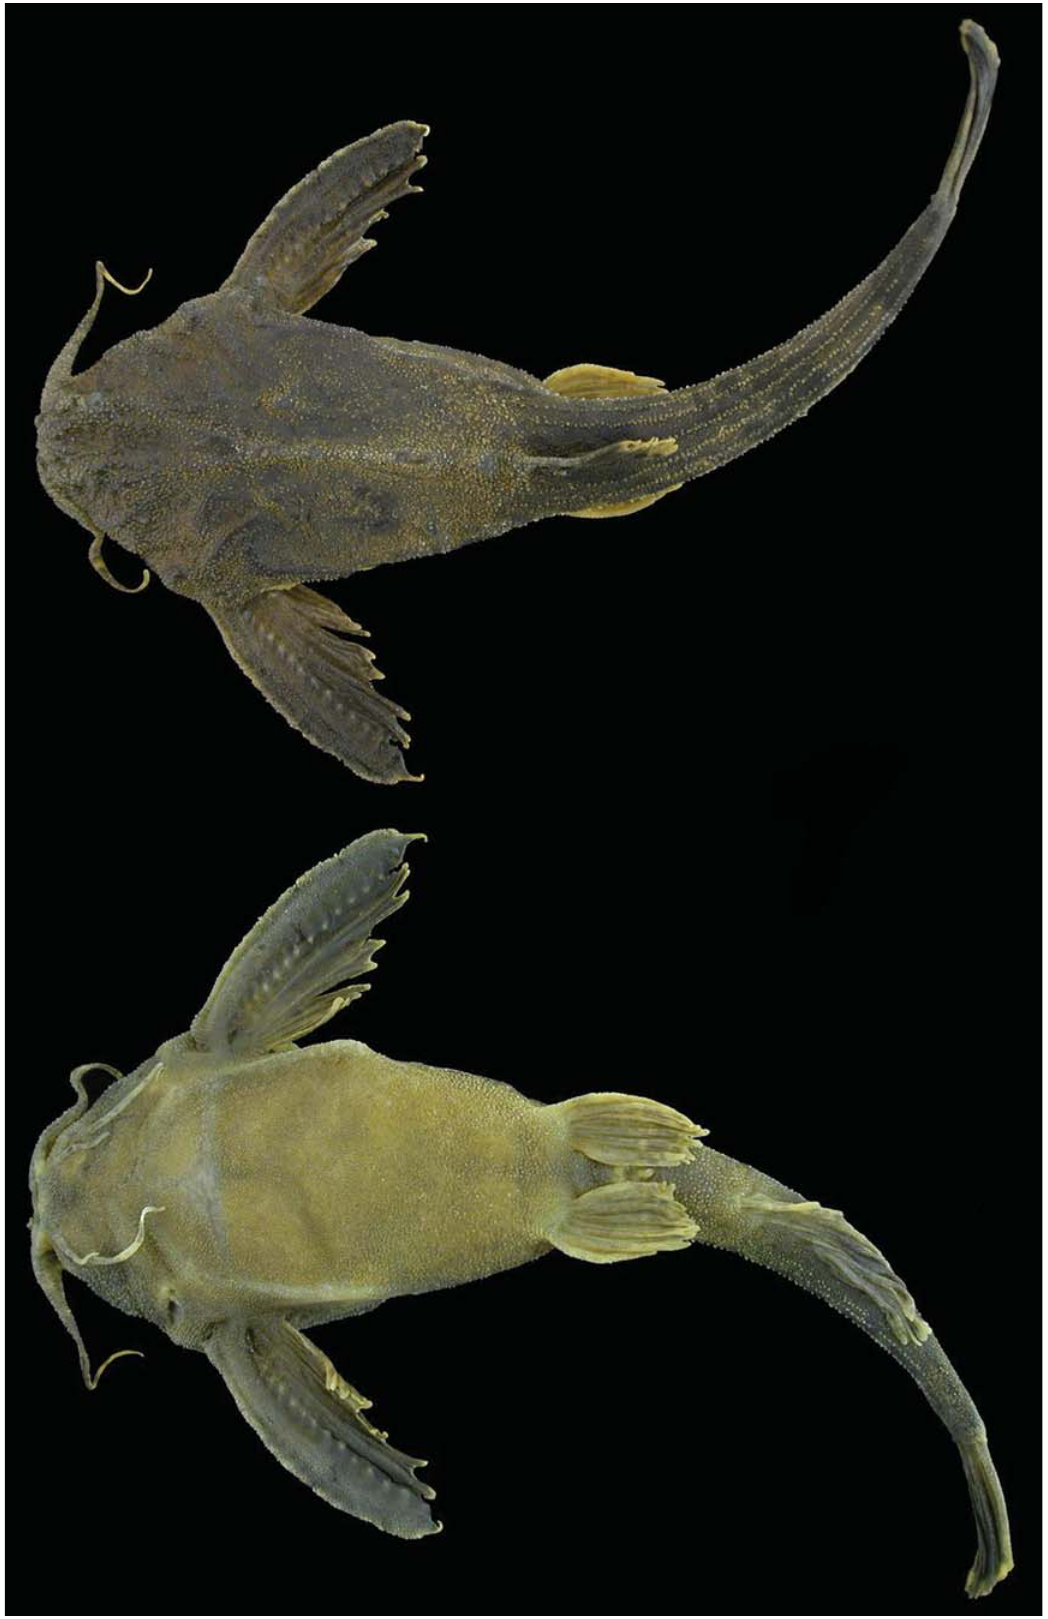
Fig. 1. Bunocephalus erondinae , MCP 40877, holotype, 82.9 mm SL, canal São Gonçalo, laguna dos Patos system, Pelotas, Rio Grande do Sul,